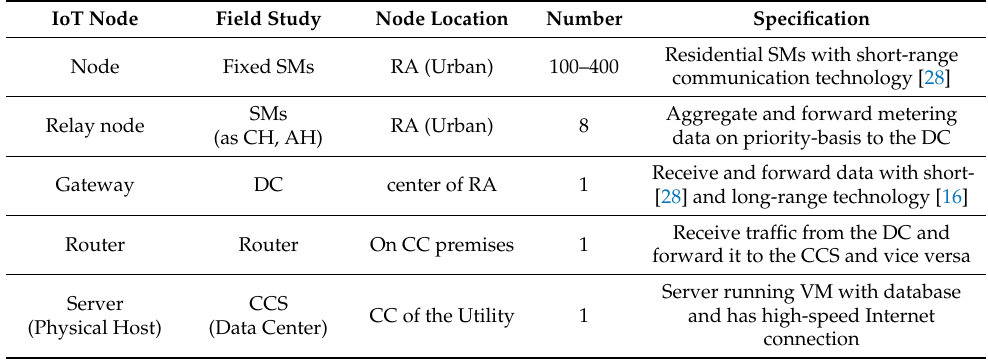
Table 3. Details of IoT nodes used in simulation for the proposed three-tier hierarchical